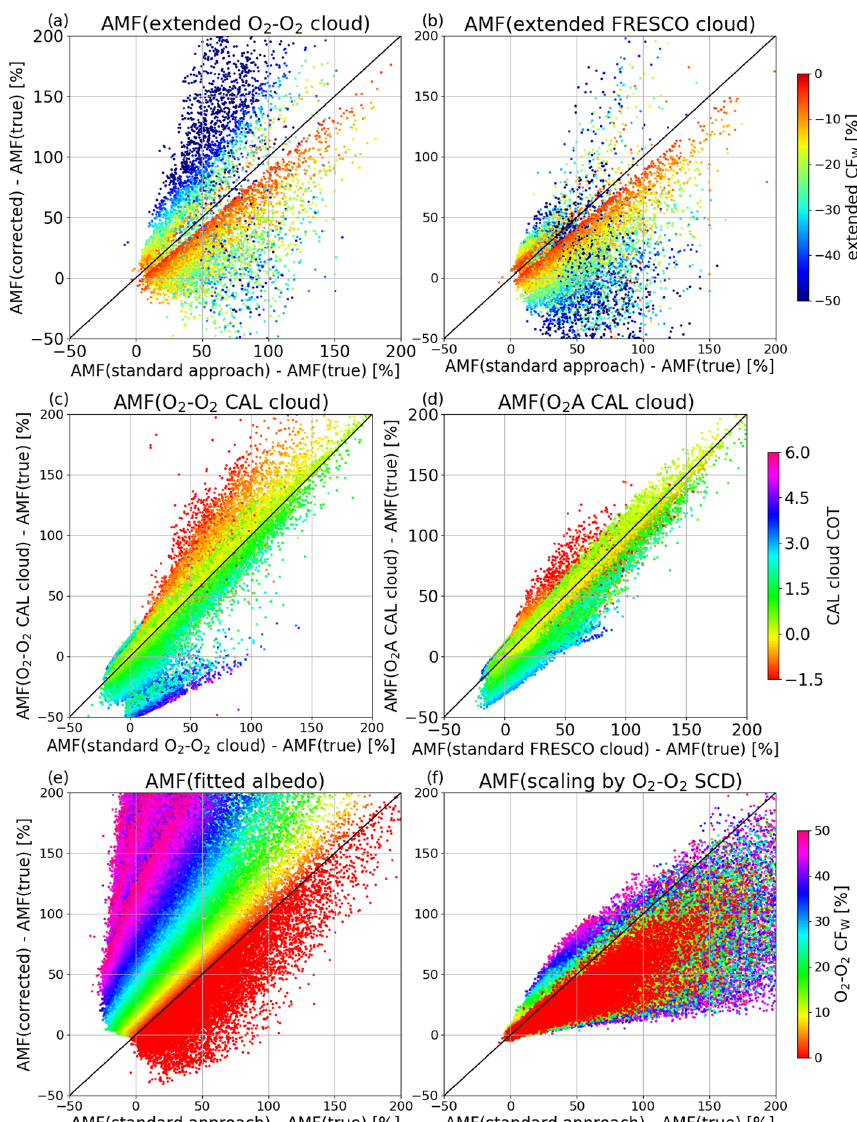
Figure 16. Comparison of the AMF bias using the standard retrieval algorithm and three correction approaches for the synthetic data with realistic LES clouds. Panels (a) – (d) show the AMF calculation based on the extended cloud retrievals, including extended standard O 2 – O 2 (a) and FRESCO (b) cloud retrieval, and the CAL retrievals based on O 2 –O 2 (c) and O 2 –A (d) absorption. (e) The corrected AMF calculated using an effective surface albedo and (f) the correction based on a scaling using O 2 –O 2 SCDs. For panels (a) and (b) , only pixels with the retrieved CF r < − 1% are included in the analysis, and for panels (c) – (f) , the pixels with the standard CF w < 50% are used. The colours represent the retrieved CF w (a, b, e, f) and COT (c, d)